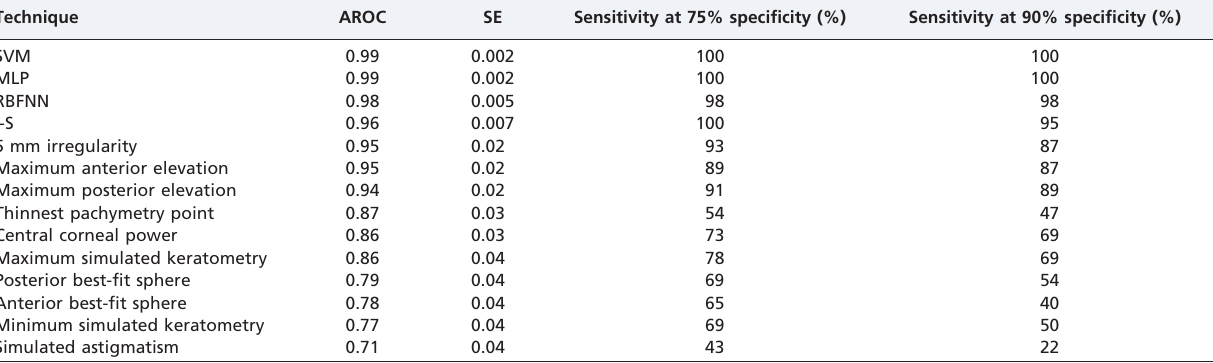
Table 2 - Areas under ROC curves and sensitivities at fixed specificities for detecting keratoconus apart from all other patterns for all techniques and